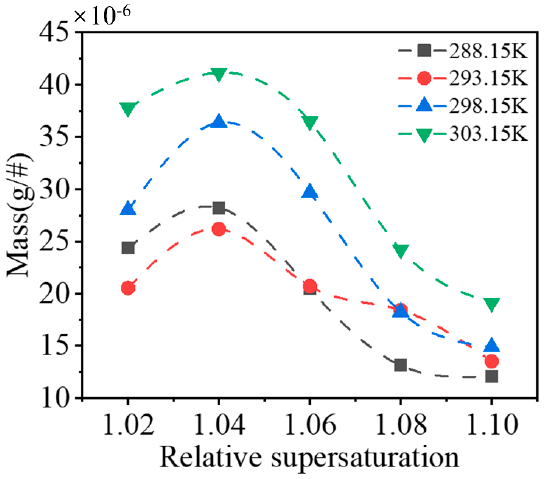
Figure 8. Final crystal suspension density of experiments conducted with 5 crystal seeds at 200 rpm. Figure 9. Mass of single crystals in experiments conducted with 5 crystal seeds at 200 rpm.